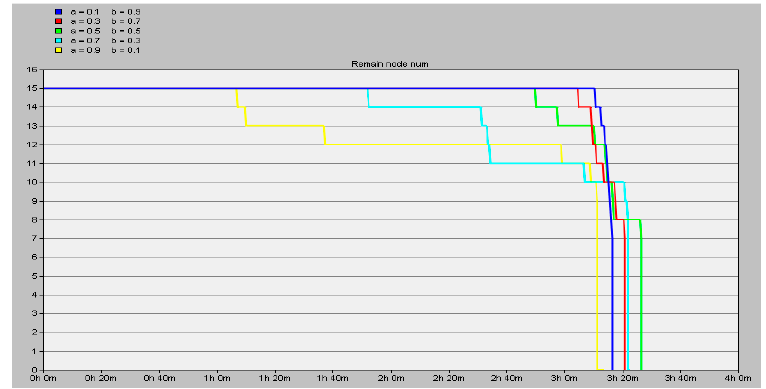
Figure 12. The number of remaining nodes in the network.